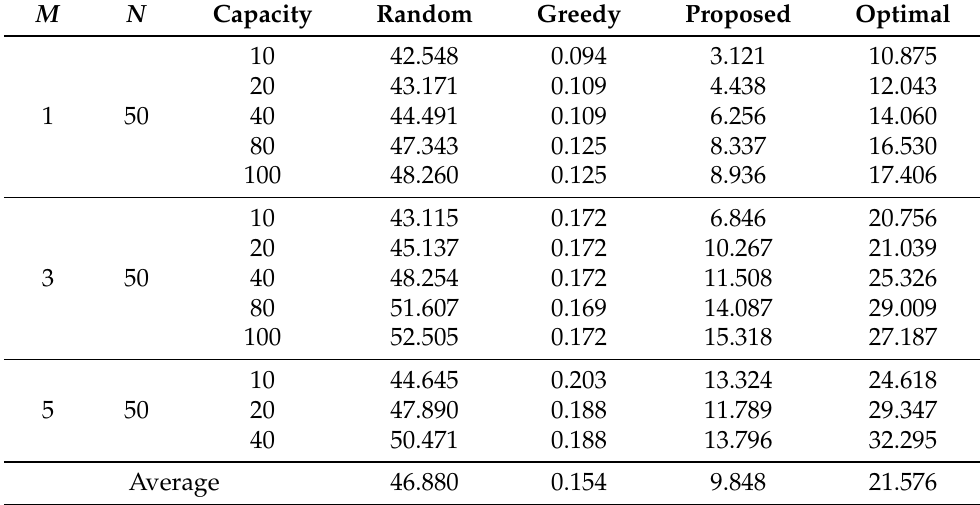
Table 13. Computation time (seconds) in RI.